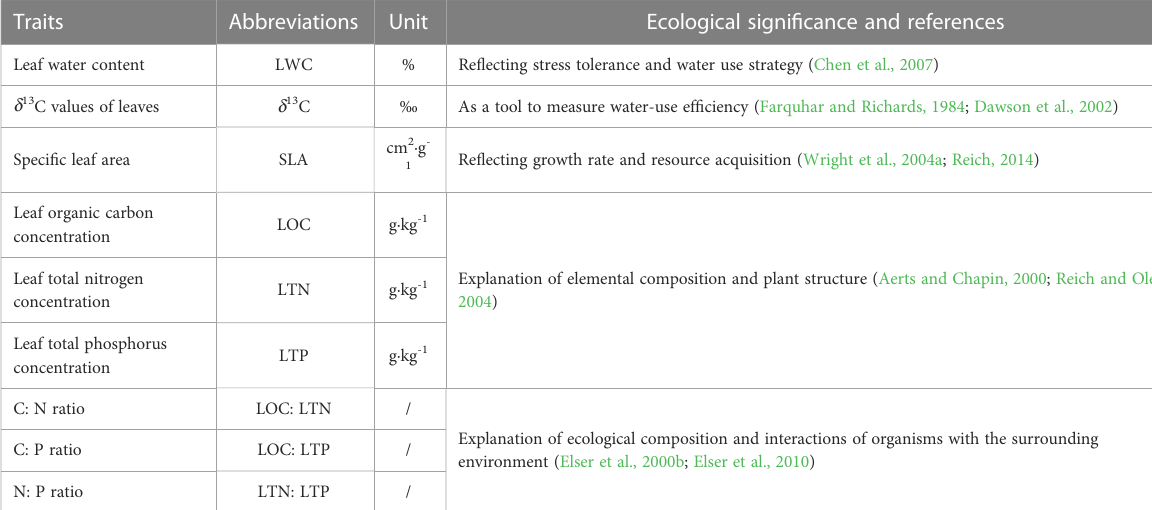
TABLE 2 List of leaf functional traits and their ecological signi fi cance. Traits